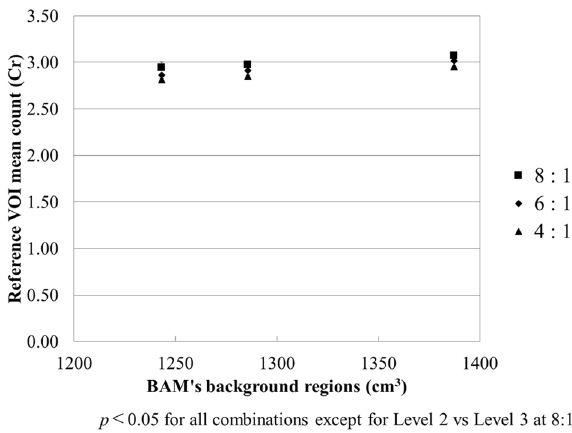
Figure 7. Relationship between Cr and the volume of BAM background regions. Cr decreased linearly with the increasing volume of BAM background regions.